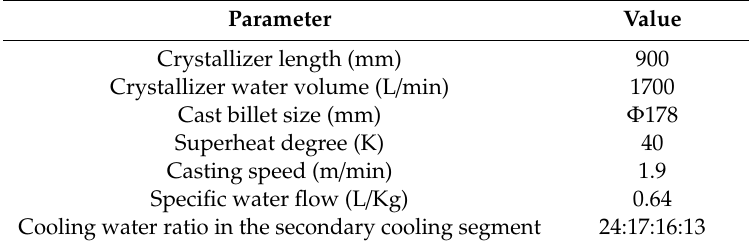
Table 2. Process parameters of the round billet continuous casting machine.